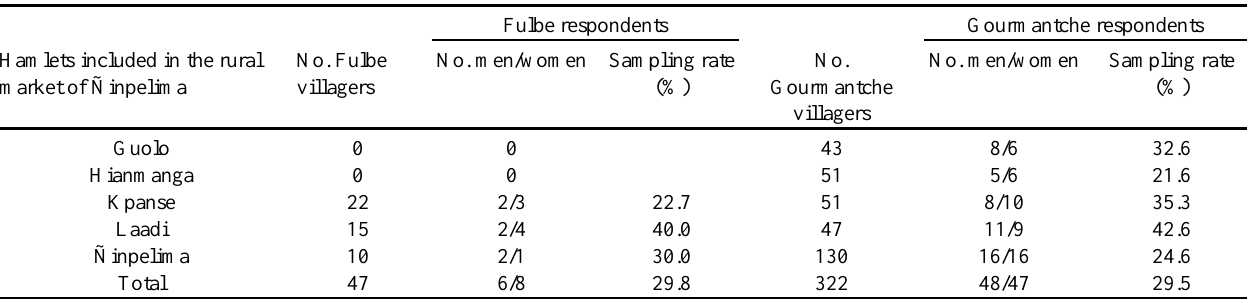
Table 1 . Sampling in the Ñinpelima survey. Fulbe respondents Gourmantche